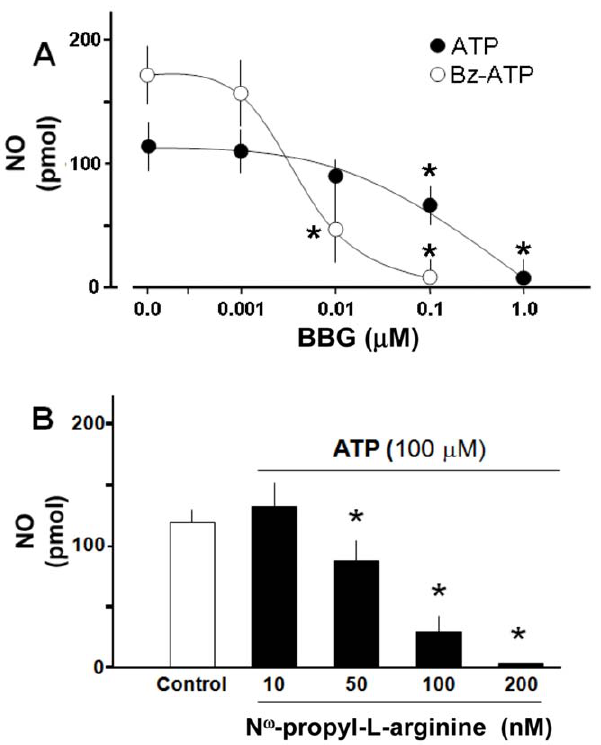
Figure 2. NO production increased by ATP or Bz-ATP involves P2X 7 R and nNOS activation in hippocampal slices. ( A ): BBG, a selective P2X 7 receptor antagonist, inhibits in a concentration- dependent manner the production of NO mediated by 100 m M ATP or 100 m M Bz-ATP. ( B ): N v -propyl-L-arginine, the selective nNOS inhibitor reduces the NO production elicited by ATP in a concentra- tion-dependent manner. Results represent the mean 6 S.E.M, of triplicate experiments, (n=3–5 separate experiments). Student’s t-test *p , 0.05 among nucleotides (A), or as compared to control (B); **p , 0.01.